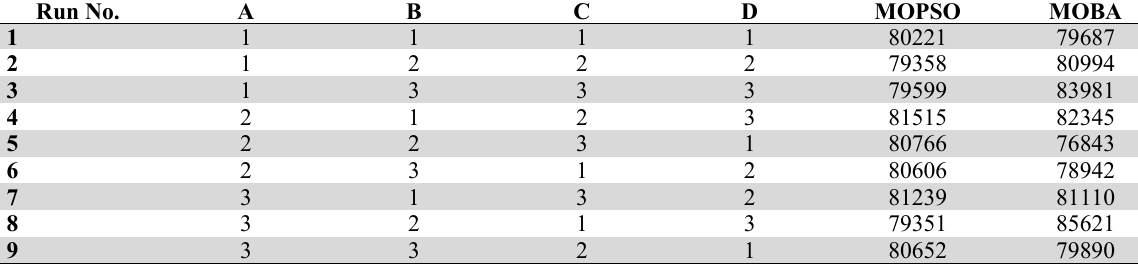
Taguchi L 9 formulation with objective function value (WIP inventory model) Run